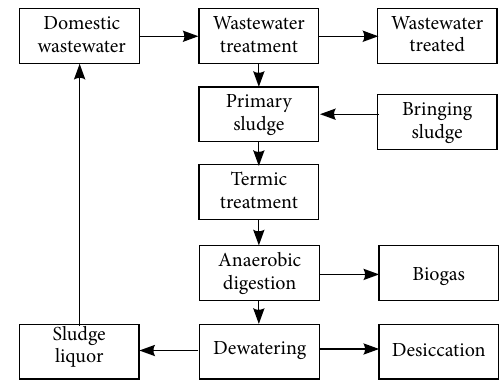
Fig. 2. Conventional technological processes of